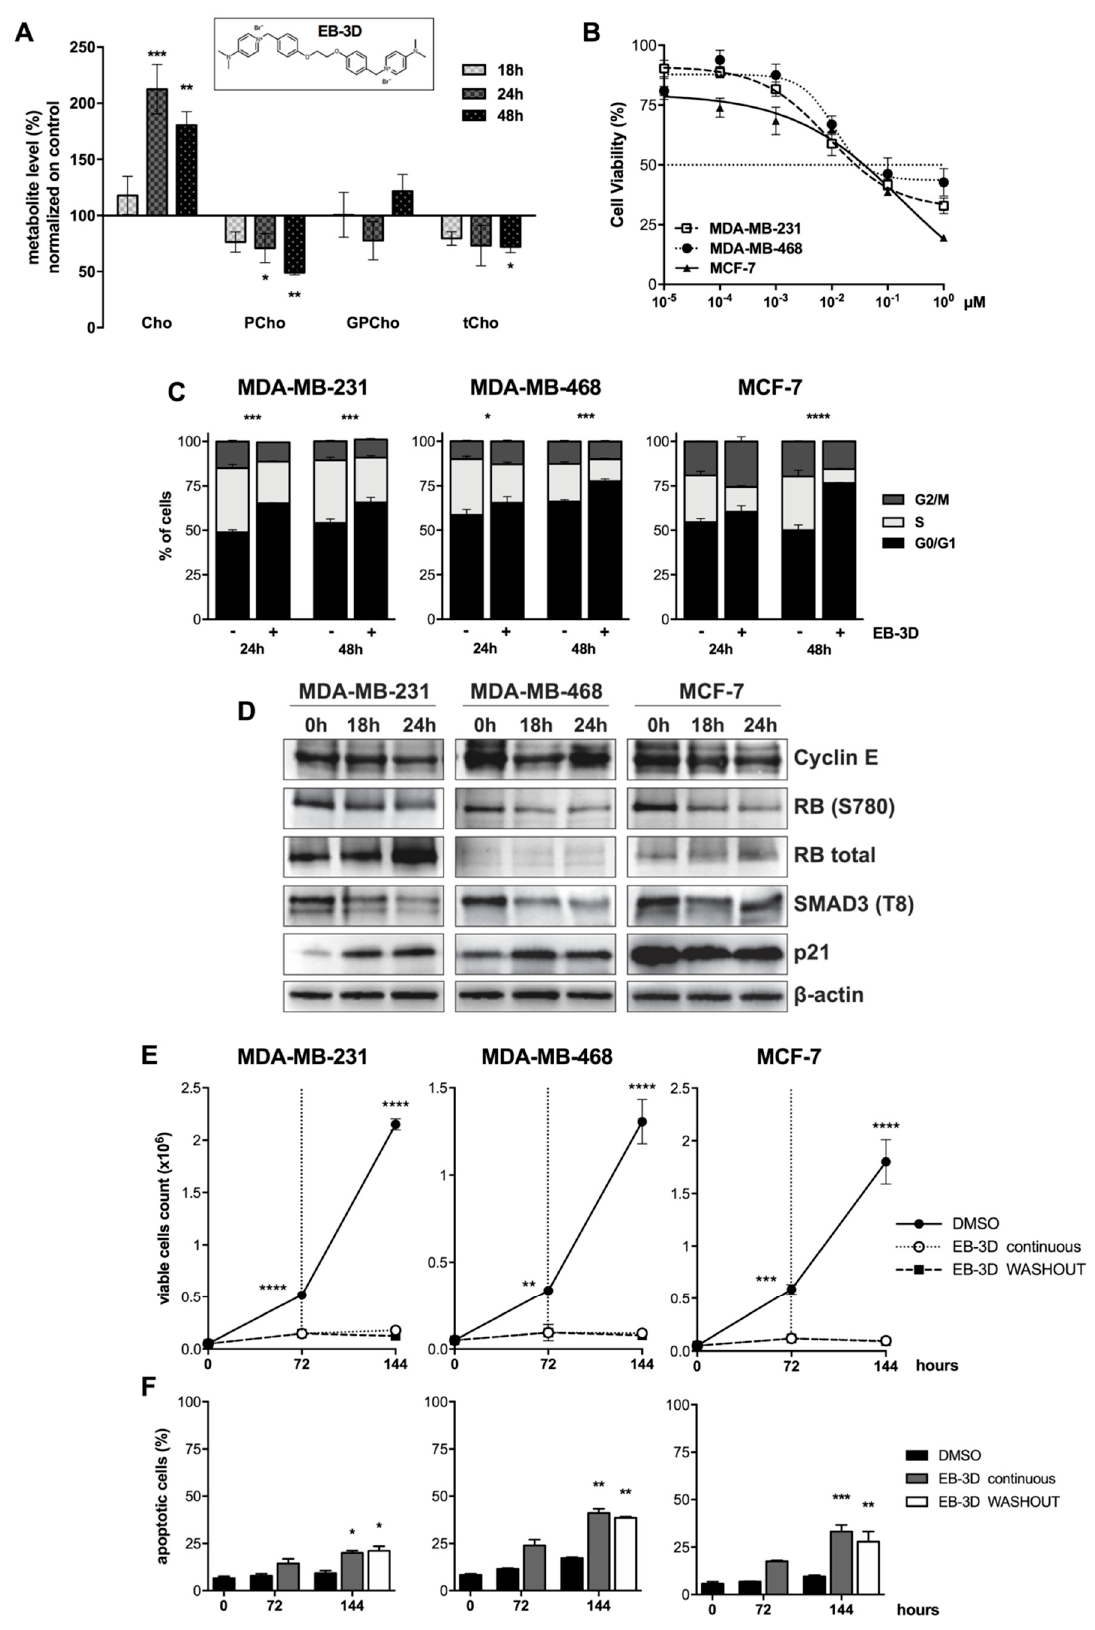
Figure 1. Effect of EB-3D choline kinase α (ChoK α ) inhibition in breast cancer cells. ( A ) Levels of choline (Cho), phosphocholine (PCho), glycerophosphocholine (GPCho), and total choline-containing compounds (tCho) quantified from 1H-NMR spectra of water-soluble extracts from MDA-MB-231 cells treated with DMSO or 1 μ M of EB-3D (chemical structure shown in the inset) for the indicated time points. Metabolite levels are expressed as a percentage with respect to the control. ( B ) MTT cell